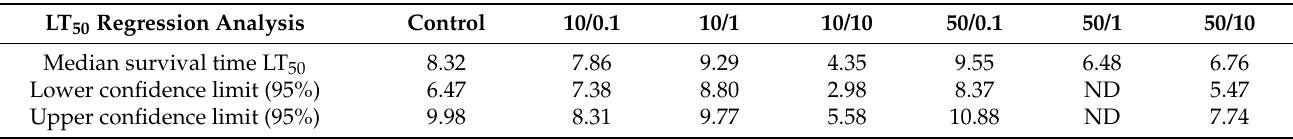
Figure 2. Cumulative survival of the control mussels and mussels exposed to different concentrations of 10 μ m and 50 μ m PMMA particles through time. The legend indicates the microparticle size (10, 50 μ m)/concentration (0.1, 1, 10 mg L − 1 ), with the control group denoted as CON. Table 1. LT 50 values of the control mussels and mussels exposed to different concentrations of 10 μ m and 50 μ m PMMA particles.